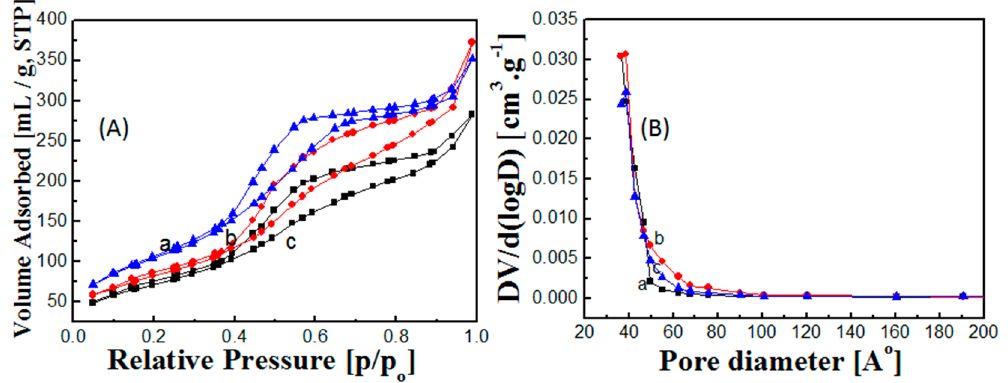
Figure 2. ( A ) N 2 adsorption-desorption isotherms and ( B ) pore size distribution of (a) non-functionalized, (b) amino-functionalized and (c) ethane-functionalized of hollow core-mesoporous shell silica nanospheres.